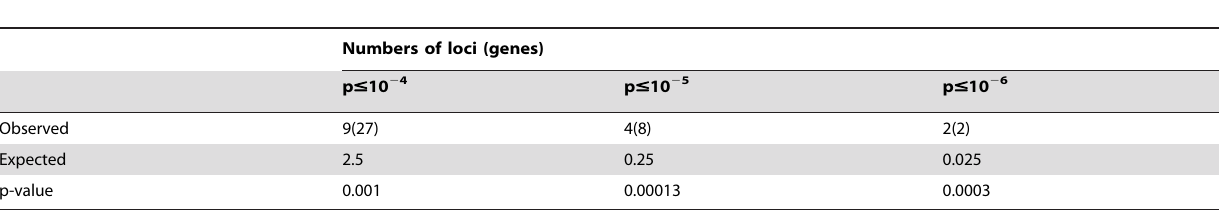
Table 2. Overrepresentation of significant loci, excluding regions of 0.5 Mb around previously reported[4–8] and Stage 1 IGAP genes[9,19] containing genome-wide significant